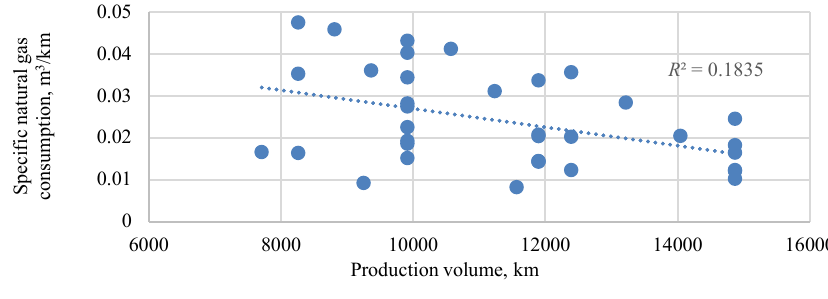
Fig. 4. Linear regression analysis for specific natural gas consumption .